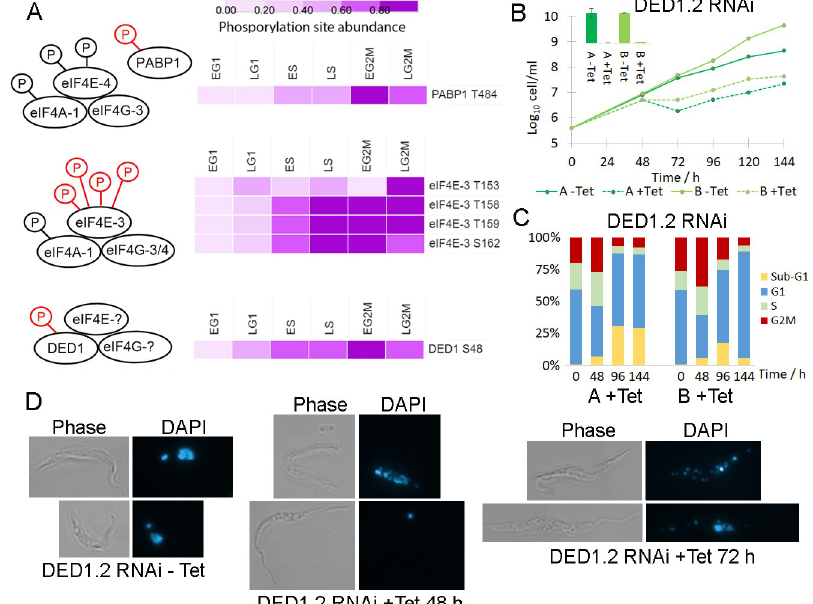
Fig 7. Dynamic phosphorylation of the translational machinery. A. Schematic of eIF4F complexes with CCR phosphorylation sites rendered as a heat map of fold change scaled to the unit integer. The components bound to DED1 have not been identified in T . brucei . B. Cumulative growth curve of tetracycline inducible RNAi of DED1.2 in two independent clones, with qRT-PCR inset confirming ablation of DED1.2 mRNA at 48h. C. Flow cytometry analysis of DNA content of DED1.2 RNAi time course shows accumulation of a sub-G1 population. D. Microscopy of DAPI stained DED1.2 RNAi time course shows disintegration of nuclear integrity. A second Tb eIF4F complex composed of Tb eIF4A-1, Tb eIF4E-3, and either Tb eIF4G-3 or